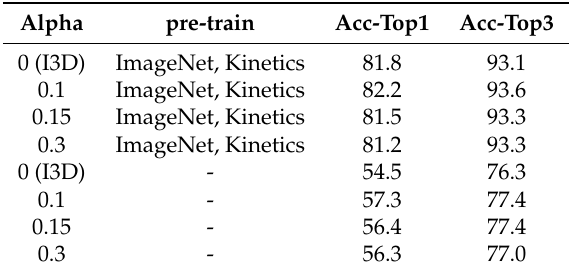
Table 2. Experimental result of changing alpha value on HMDB-51.